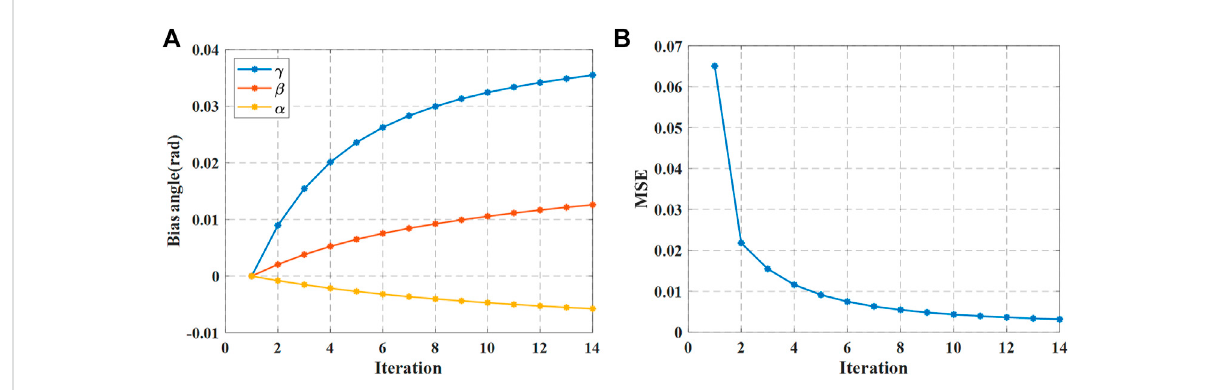
FIGURE 8 LM algorithm optimization results of calibration (A) optimization results of three-axis attitude Angle under different iterations (B) MSE of two point clouds.